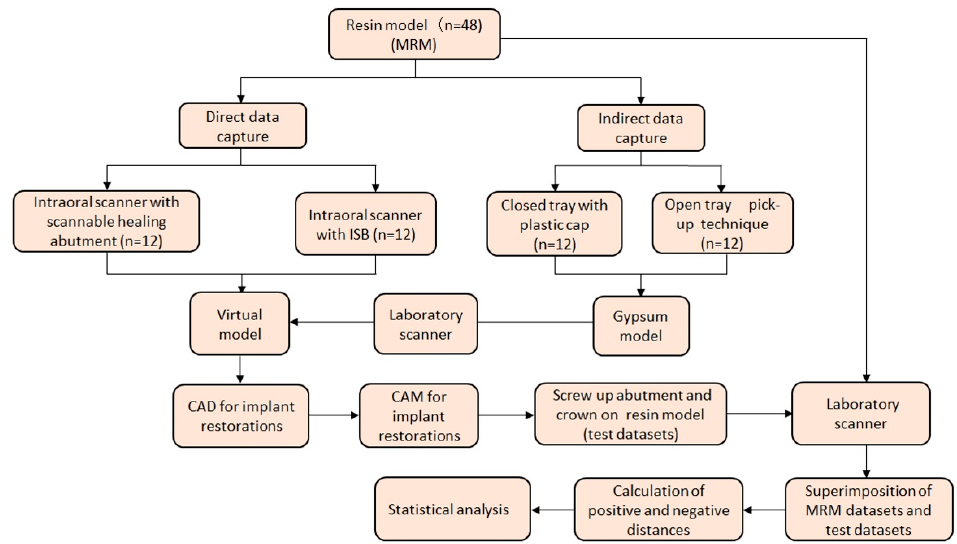
Figure 1. Experimental design. MRM: master reference model; ISB: intraoral scan body; CAD/CAM: computer-aided design/computer-assisted manufacturing.